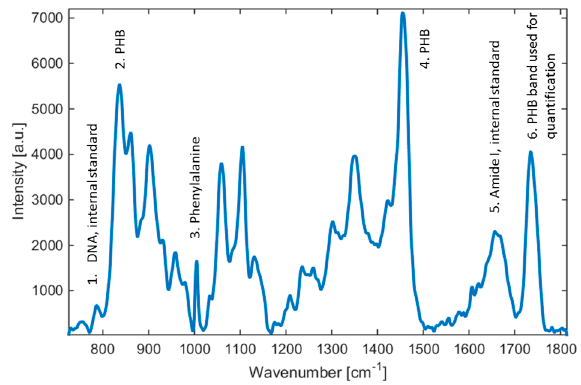
Figure 1 Raman spectra of Cupriavidus necator H16. Selected emission lines used in our study are highlighted. Note that peaks 1, 5, and 6 can be used for analysis of PHB in the bacteria sample—peak 6 represents the PHB band used in this study, peak 5 is an internal standard (Amide I), and peak 1 is a second internal standard (DNA).